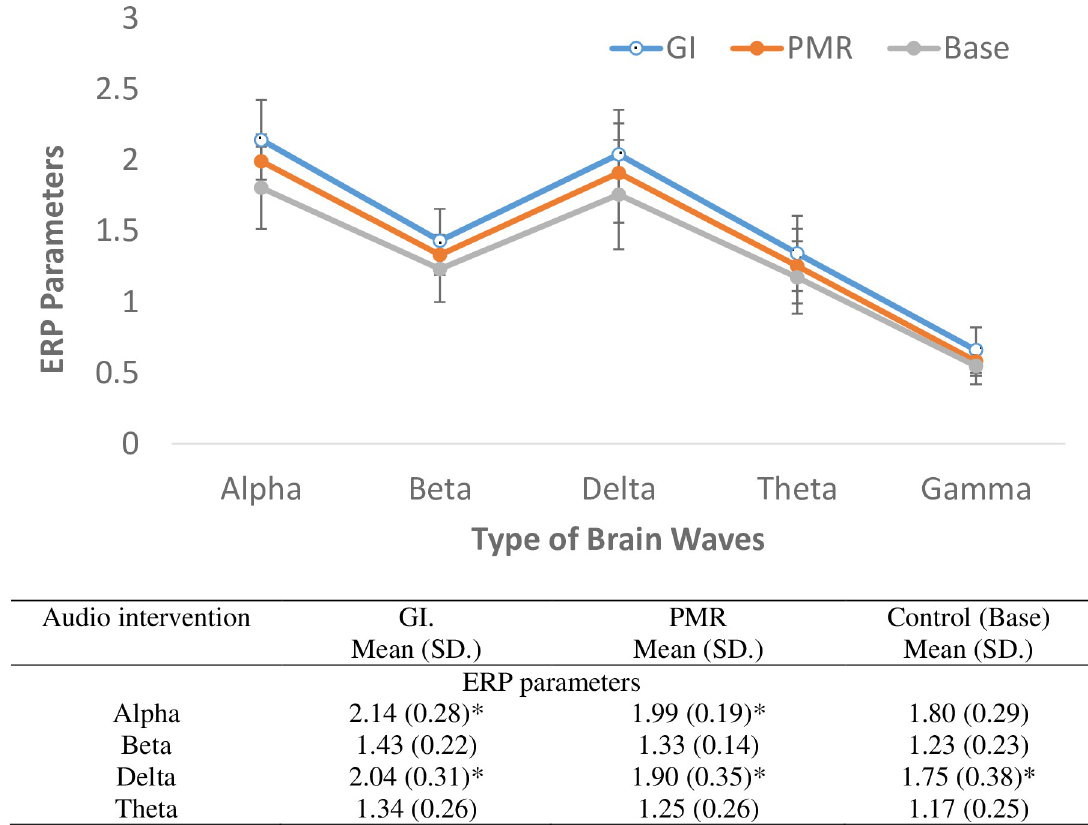
Fig 2. Reported values, pairwise comparison, and RM-ANOVA analysis of ERP parameters between guided imagery, progressive muscle relaxation and controls. GI: Guided imagery, PMR: Progressive muscle relaxation, ERP: Brain event-related potentials. � Significant mean difference based on pairwise comparison in alpha waves between GI and PMR (p = 0.029), delta waves between GI and PMR (p = 0.029) and between PMR and control (p = 0.014).